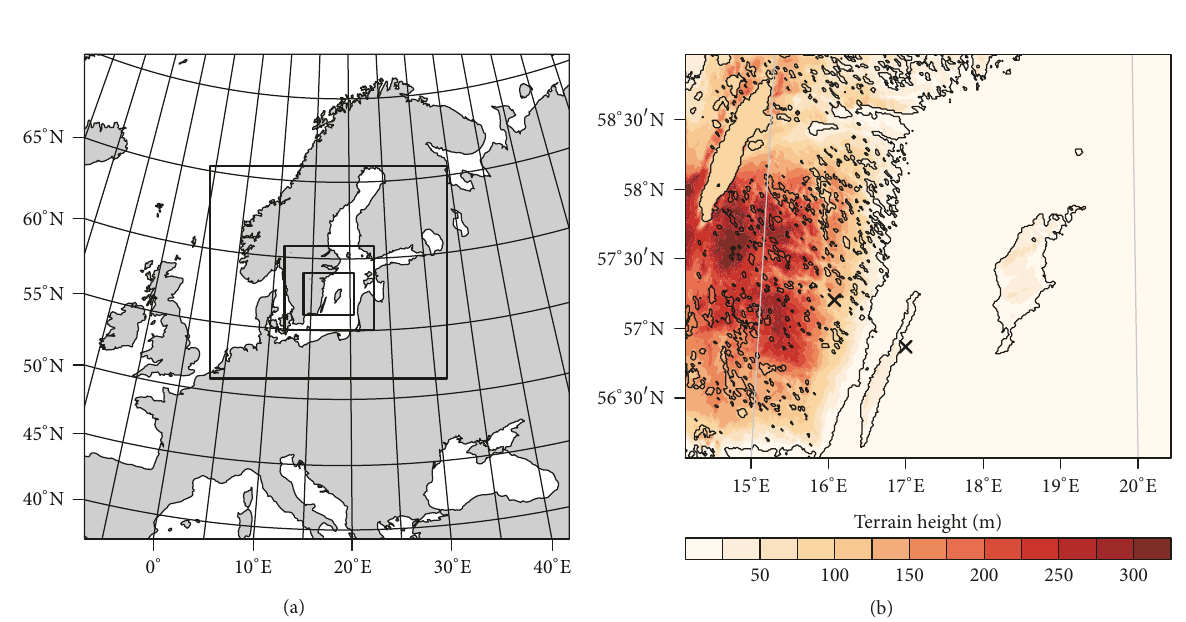
Figure 2: (a) WRF model domain setup, showing the outer domain and three nested inner domains marked by the black rectangles. (b) Terrain height in the innermost model domain. The crosses show the location of the two meteorological towers used in the study. The two largest islands in the domain are the islands of ¨Oland (westernmost) and Gotland